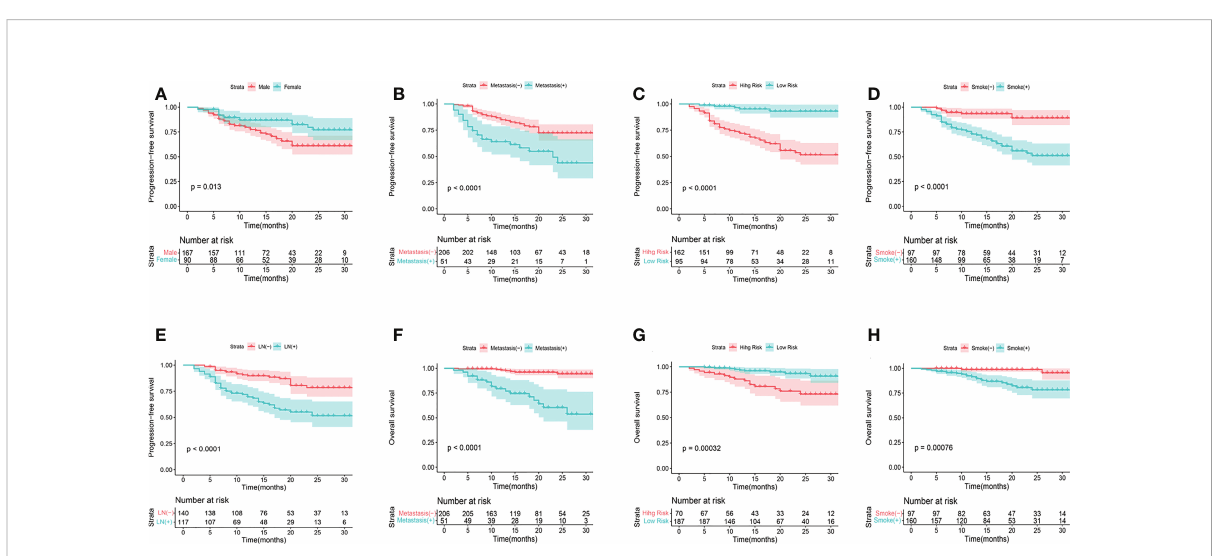
FIGURE 2 KM analyses for PFS (A-E) and OS (F-H) according to gender, metastasis, smoking history, R-signatures, and lymph node metastasis in the training cohort.